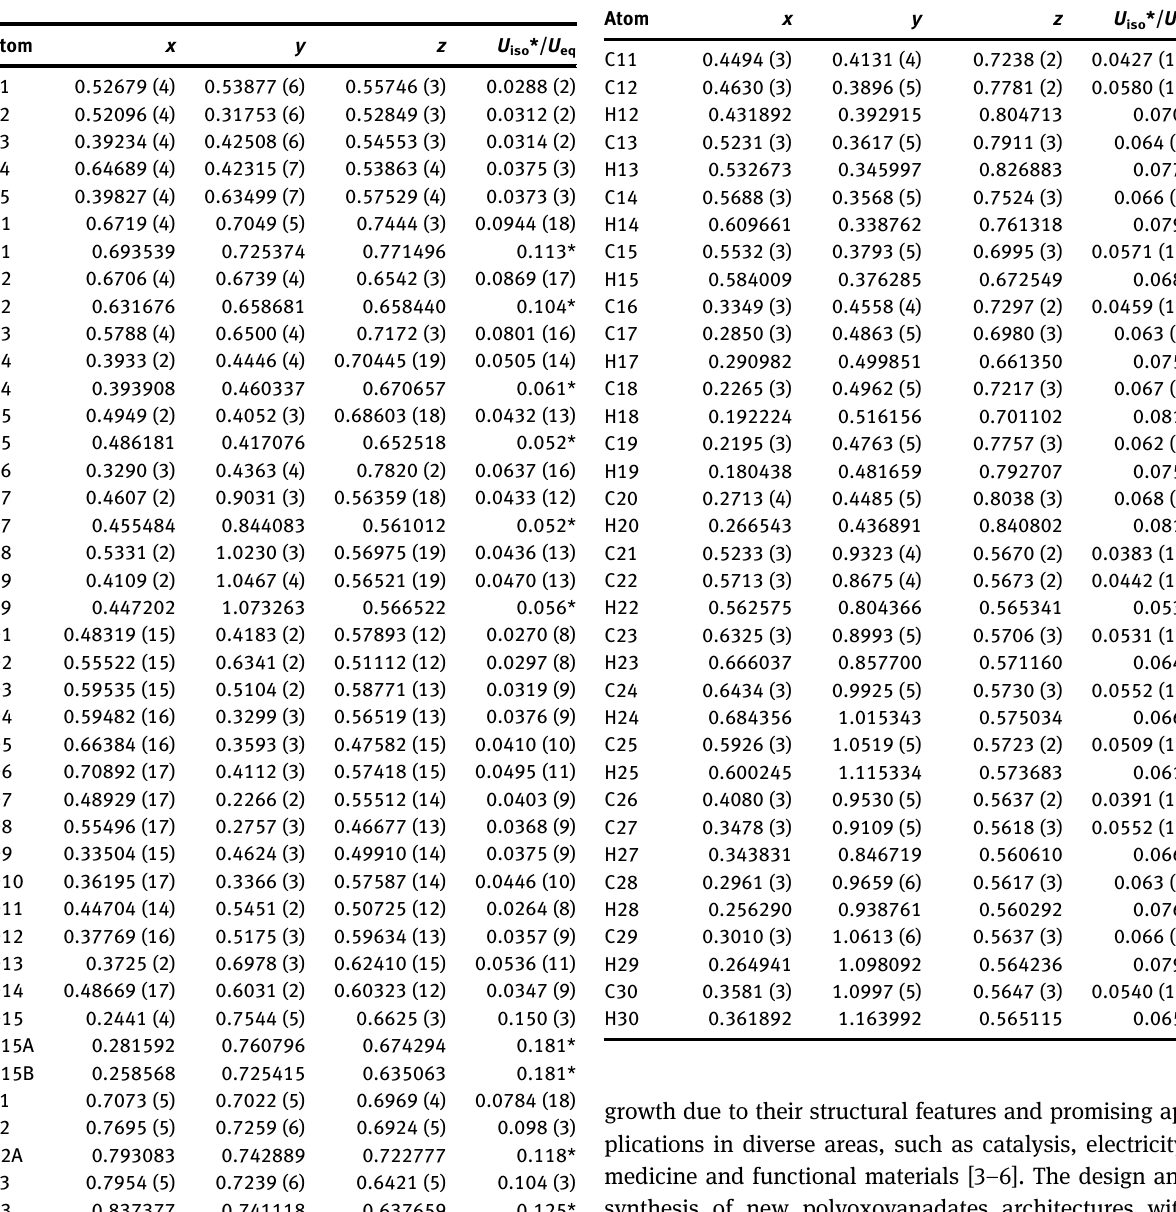
Table  : Fractional atomic coordinates and isotropic or equivalent isotropic displacement parameters (Å 